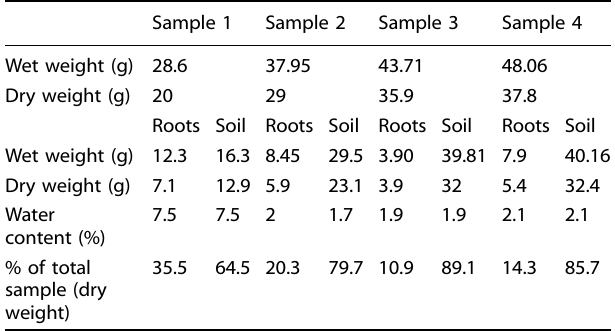
Fig. 3 Correlation matrix between the abundance of micropollutants of interest and the physico-chemical properties of the soil in the in fi ltration pond. Correlation coef fi cients were calculated using Spearman ’ s correlation; positive coef fi cients (red) indicate a positive relationship between the variables, and negative coef fi cients (blue) indicate a negative relationship. Values near zero (white) indicate no relationship between the variables. Correlation coef fi cients are indicated only if P < 0.05; asterisks indicate P < 0.01 (*) and P < 0.001 (**). N = 9 (aniline compounds), 24 (pyrethrins), 27 (PAHs). d10, 1.26 – 1.38 µm particles; d50, 20.7 – 22.73 µm particles; d99, 101.1 – 161.2 µm particles. Table 1. Determination of roots and soil proportions in soil